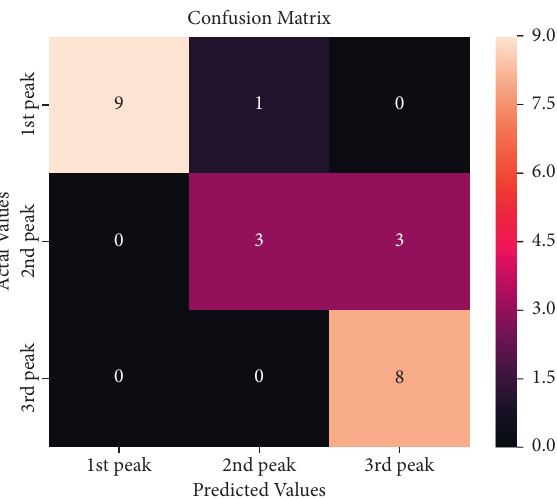
Figure 6: Confusion matrix of the SVM